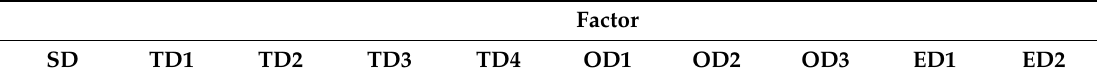
Table 2. Factor analysis and alpha